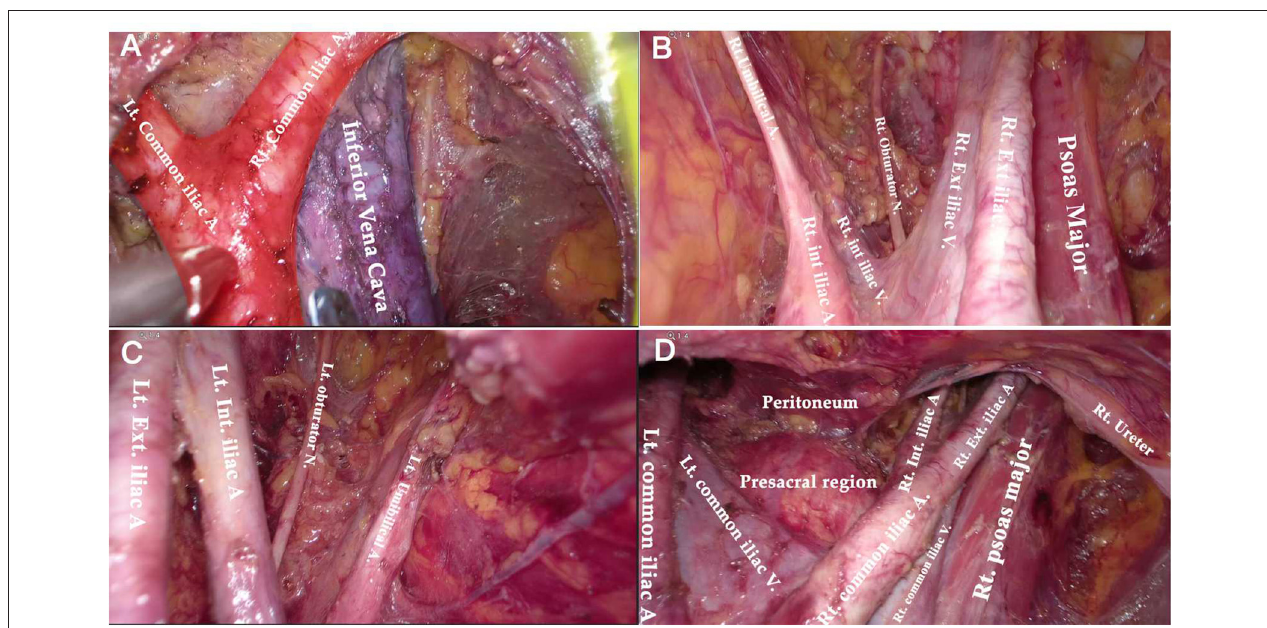
FIGURE 6 | Anatomical overview of pelvic area after PLN. (A) The aortic bifurcation and inferior vena cava. (B) The right obturator fossa. (C) The left obturator fossa. (D) The view of presacral area.